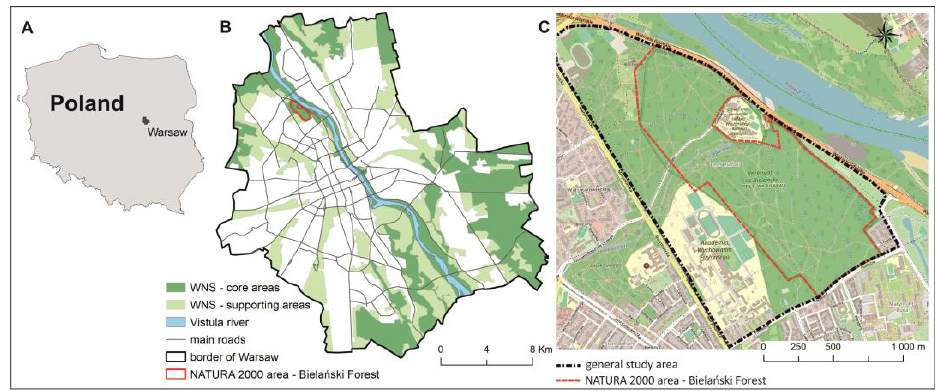
Figure 1. Area of the study (own elaboration): ( A )—Warsaw on the map of Poland, ( B )—Bielański Forest as an element of Warsaw Natural System (WNS), ( C )—map of Bielański Forest. The study area is diverse in terms of its geomorphology, water conditions and the structure of its habitats. There are four terraces running parallel to the Vistula River: a flood terrace, a higher terrace (an alluvial one), an ice valley of the Vistula, and a moraine plateau called Bielański terrace. The area of the flood terrace is closest to the Vistula, covering the valley of Rudawka Stream. The groundwater level in this area depends on the water level of the Vistula and ranges from 0.0 to 2.0 m below the ground level [5,33]. The area is covered with an elm-ash forest (Ficario-Ulmetum), which is rarely found in urban areas. The current water conditions are within the tolerance levels of the plant species occurring in this area. It is the most natural part of Bielański Forest. The area of the higher flood terrace is mostly covered by the oak-hornbeam forest (fertile variant, Tilio-Carpinetum) and, in a few locations, by an elm-ash forest (a drier variant of Ficario-Ulmetum with hornbeam). Numerous old trees can be found in these parts. In the southern part of the site, above the flood terrace, there is a sandy terrace of the Vistula proglacial valley. In some places, small elongated hills, now overgrown with pine trees, are still visible. The moraine plateau is the highest part of the site in terms of elevation. The terrace is bordered by an escarpment rising 6–15 m above the Vistula River valley. The groundwater level lies at a depth of 5–10 p.p.t., and locally even deeper [33]. This part of the area is covered with high oak-hornbeam forest of a drier variant (Tilio-Carpinetum Typicum). Some of the old oak stands are about 300–400 years old.